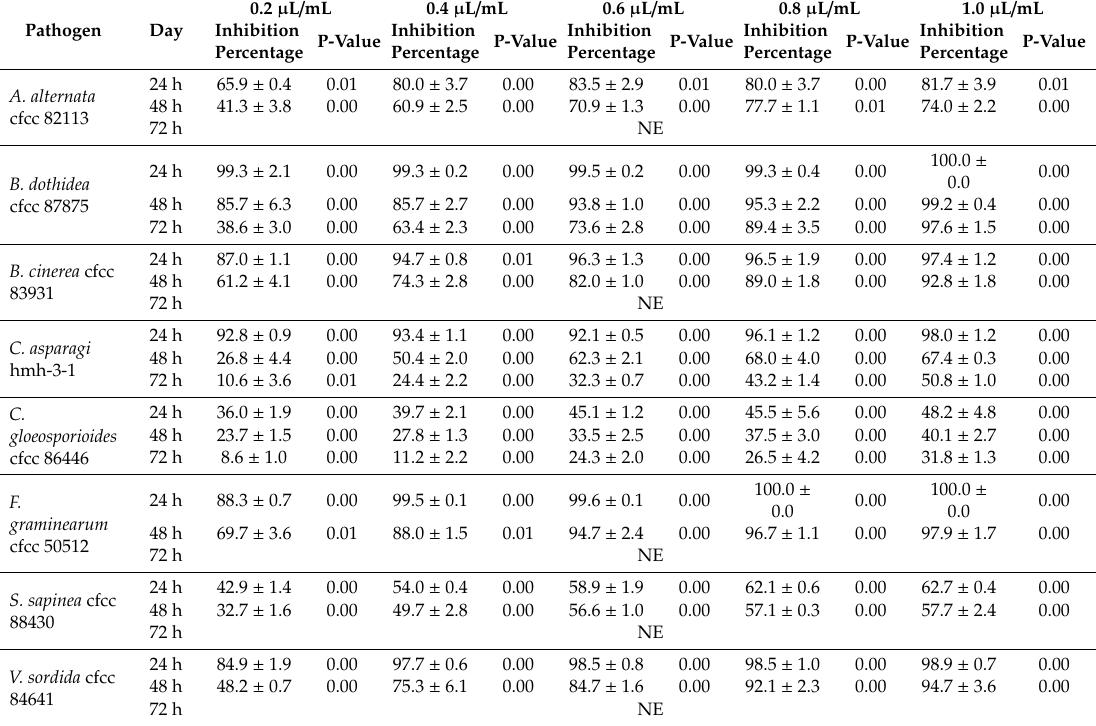
Table 7. E ff ects of mixtures ( α -terpinene: γ -terpinene:(-)-4-terpineol = 26:61:13) on fungal pathogens of plants determined by two-compartment Petri plate bioassay